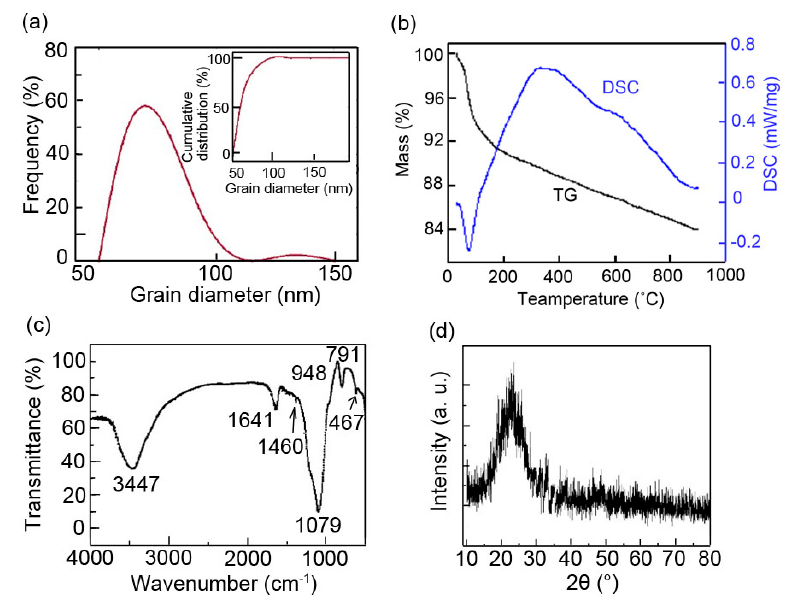
Figure 5. ( a ) The curve of the frequency distribution of nano-SiO 2 ·0.5H 2 O particles. Insert: The curve of cumulative distribution of nano-SiO 2 ·0.5H 2 O particles. ( b ) TG-DSC curve of Nano-SiO 2 ·0.5H 2 O particles. The four peaks on DSC curve at 88.3, 321.2, 713.9 and 868.8 °C correspond to the weight loss rate of 2.72%, 9.53%, 0.75%, and 0.16%, respectively. The residue rate is 83.09 % at 900 °C. ( c ) The FT-IR spectrum of Nano-SiO 2 ·0.5H 2 O particles. The peaks at 3447 cm − 1 and 1641cm − 1 are attributed to the O-H stretching vibration, while the peak at 1460 cm − 1 is attributed to the CH 2 -CH 2 scissoring vibration. The peak at 1079 cm − 1 is attributed to the Si-O bending vibration, while the peak at 948 cm − 1 is attributed to the Si-OH bending vibration, the peak at 791 cm − 1 is attributed to the O-H bending vibration, and the peak at 467 cm − 1 is attributed to the Si-O stretching vibration. ( d ) The XRD pattern of nano-SiO 2 ·0.5H 2 O particles.